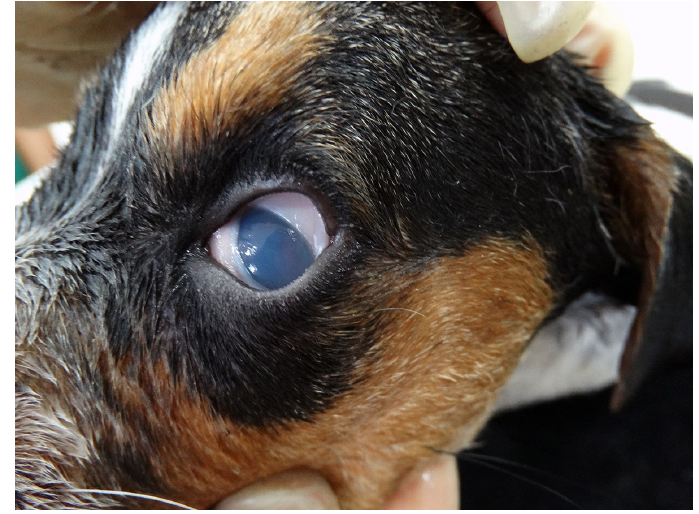
Figura 2. Olho esquerdo com opacidade de